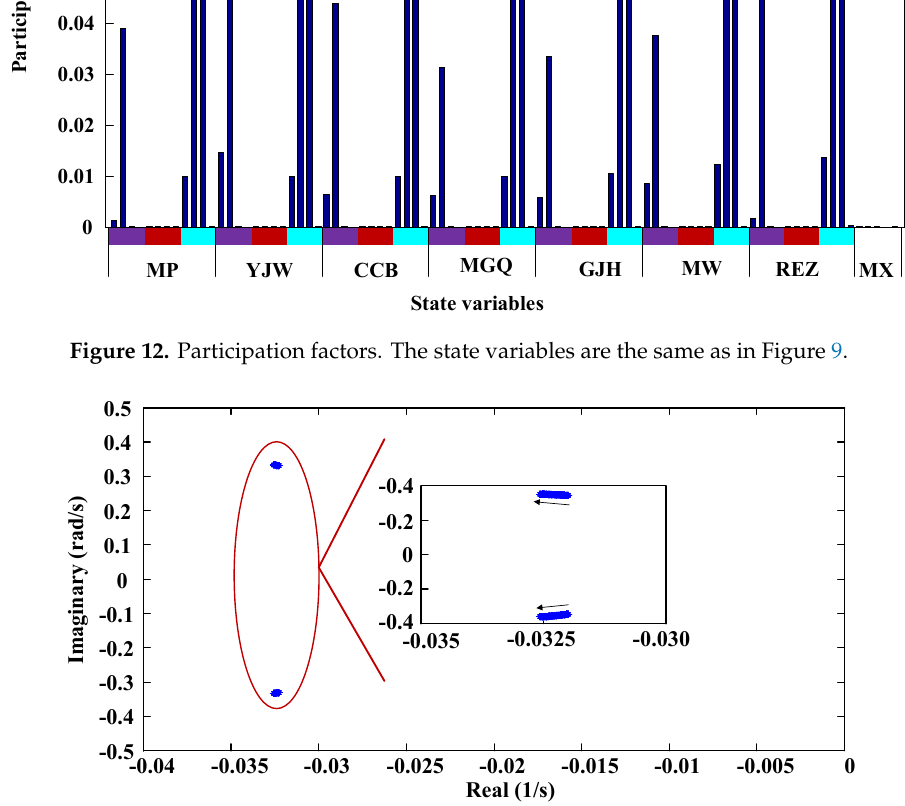
Figure 13. Root locus of the ultralow-frequency oscillation.